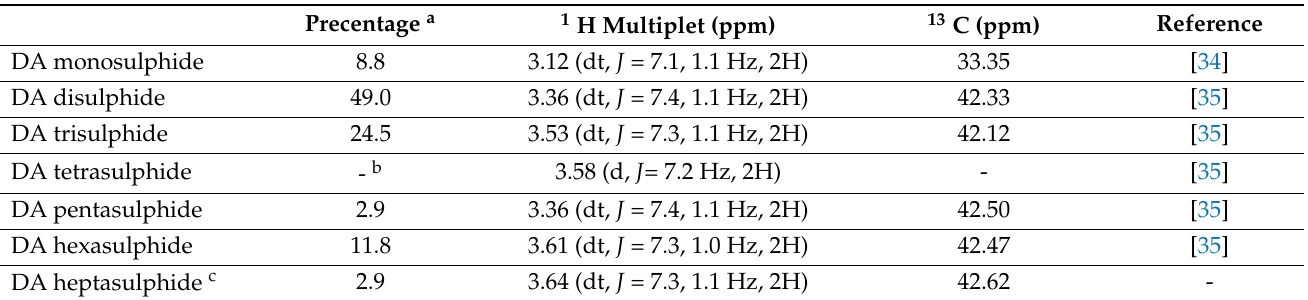
Table 12. Composition of garlic EO according to 1 H analysis.